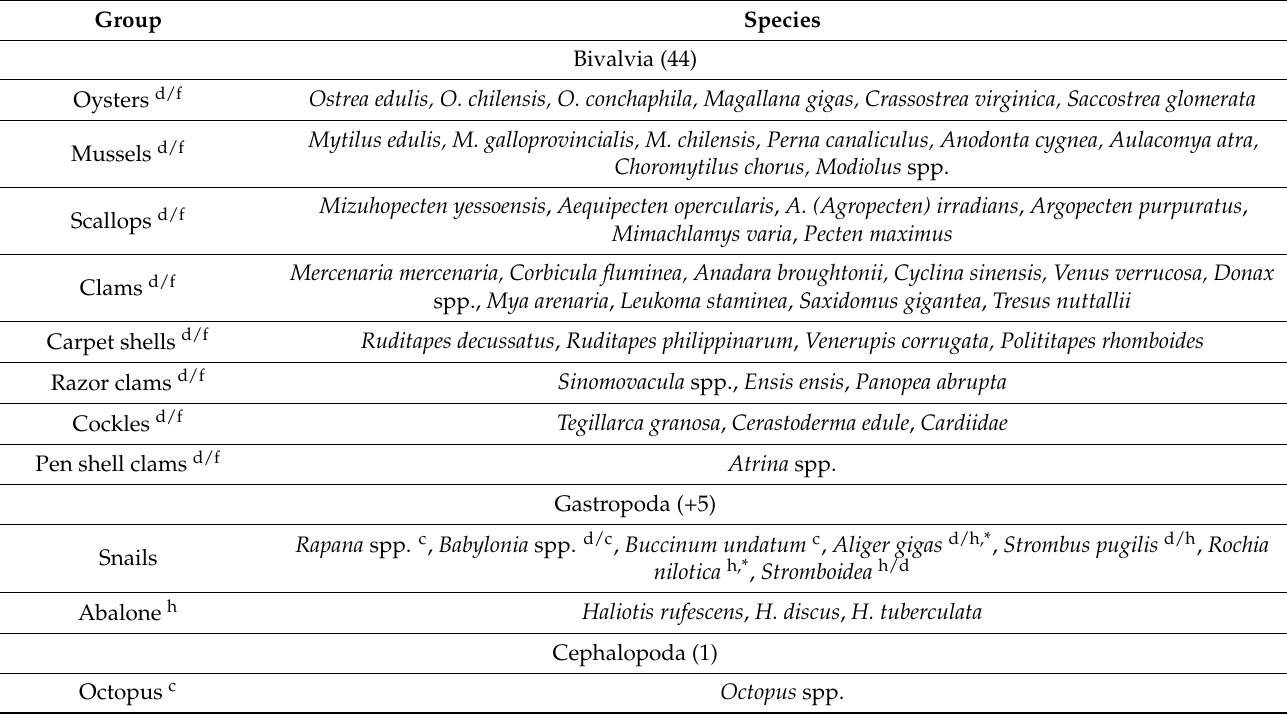
Table 4. Marine mollusks which are produced at commercial scale through aquaculture.